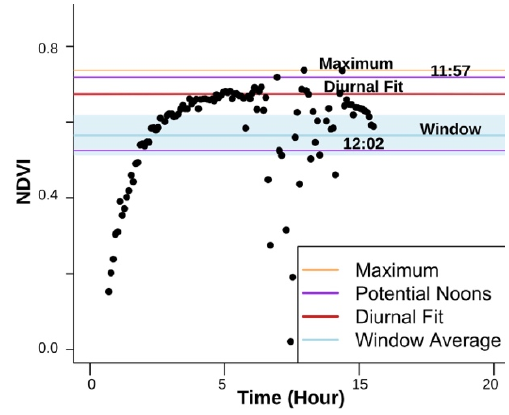
Figure 5. Plot showing that methods can produce vastly different NDVI values based on how susceptible they are to noise. The expected maximum/midday NDVI values are shown in solid lines.